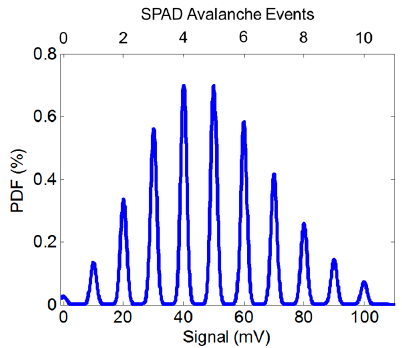
Figure 1. Photon counting histogram (PCH) generated by the read noise model with CVF equivalent of 10 mV/e, mean λ = 5 e − exposure and 0.1 e − equivalent RN.